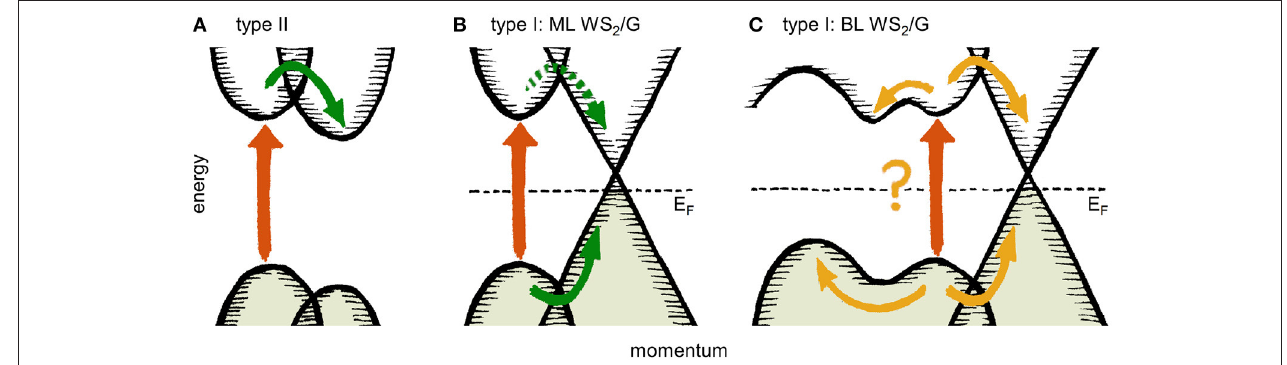
FIGURE 1 | Influence of band alignment on ultrafast charge transfer in different van der Waals heterostructures. (A) Example of a heterostructure with type II band alignment favoring electron transfer. (B) Type I band alignment of a heterostructure made of monolayer WS 2 and monolayer graphene. Both electrons and holes are found to transfer to the graphene layer albeit at different rates resulting in ultrafast charge separation. (C) Band alignment of a heterostructure made of bilayer WS 2 and monolayer graphene. The influence of the indirect band gap on the microscopic scattering channels mediating ultrafast charge transfer remains